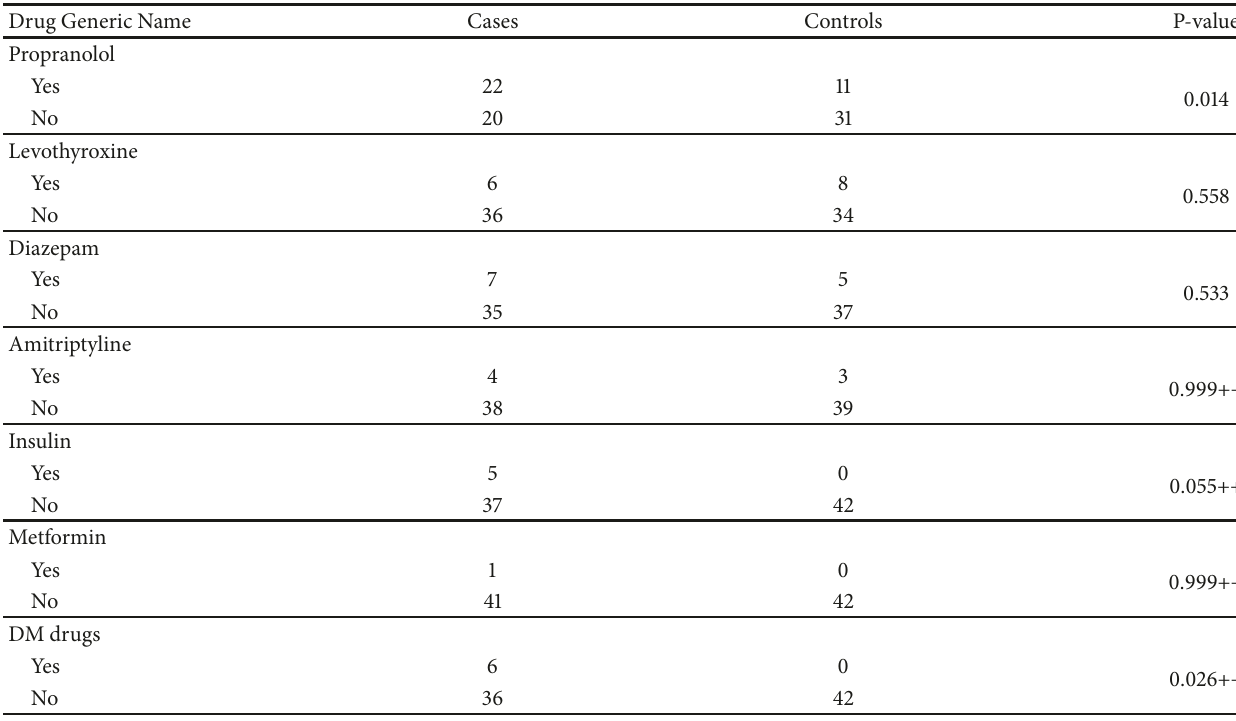
Table 3: Effect of other drug exposures (other than second-line anti-TB drugs) on the development of gout in MDR-TB patients. Drug Generic